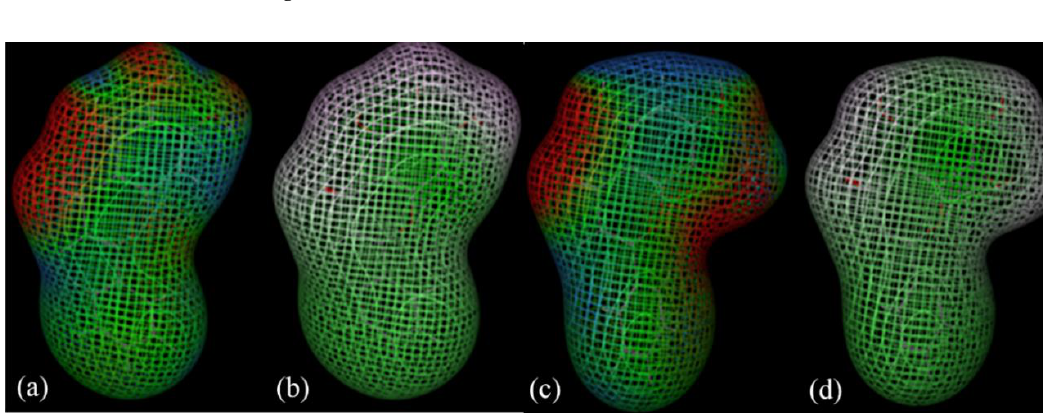
Figure 3. The spatial distribution of features of baicalein ( a , b ) and wogonin ( c , d ). In ( a , c ), electrostatic potentials are represented (red indicates negative and blue indicates positive) and in ( b , d ), amphiphilic potentials are represented (green indicates hydrophobic, violet indicates hydrophilic, and white indicates neutral).